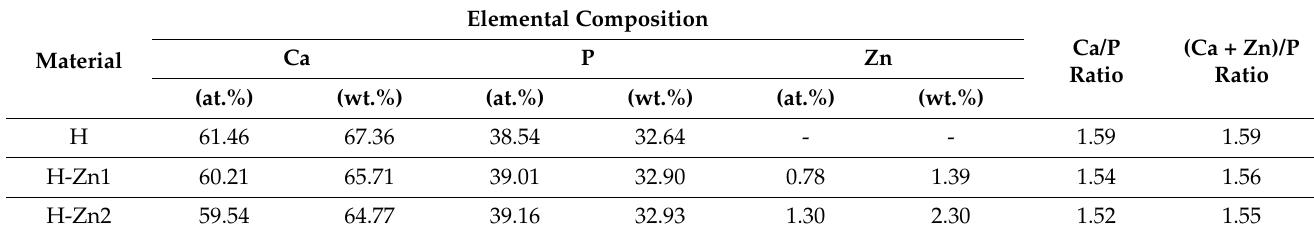
Table 2. Chemical composition (at.% and wt.% and Ca/P ratio for the coatings obtained on NT.